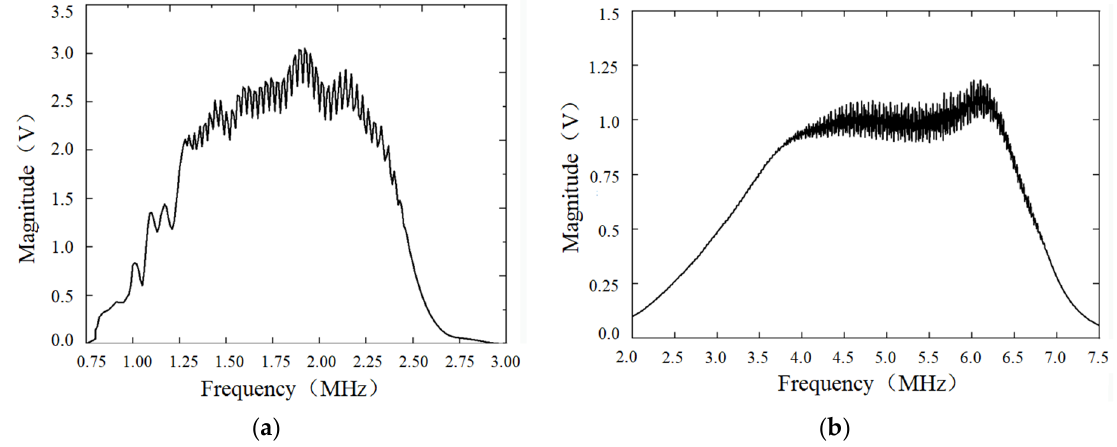
Figure 20. Spectrum of transducers with center frequencies ( a ) 1.8 MHz, ( b ) 4.6 MHz.